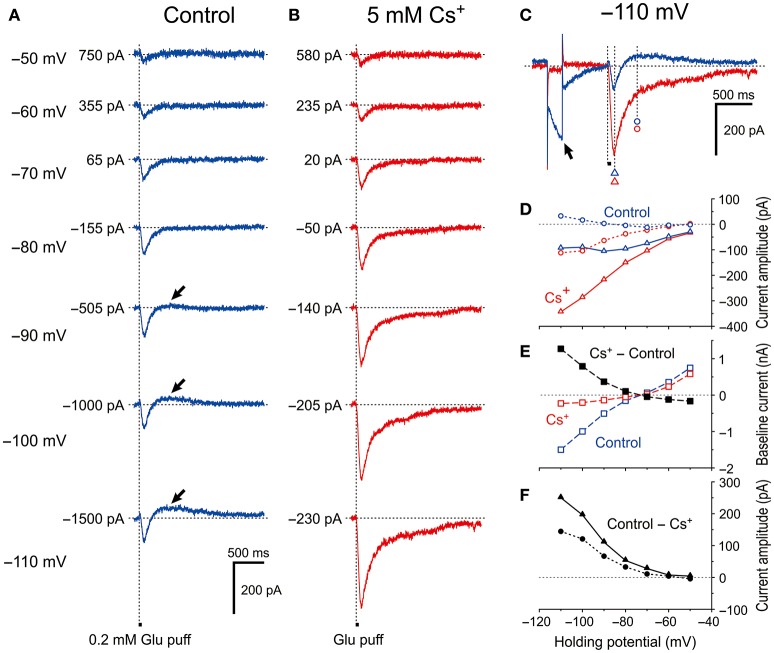
Voltage dependency of IGluR and effects of Cs+ on IGluR. (A) Current responses to 50-ms puff applications of 0.2 mM glutamate (IGluR) recorded under the voltage-clamp condition at holding potentials ranging between −110 anfd −50 mV in MTN neurons. (B) Bath application of 5 mM Cs+ outwardly shifted the baseline current level, enhanced the inward component of IGluR (IN-IGluR), and abolished the outward component of IGluR (OT-IGluR) seen at membrane potentials below −80 mV in the absence of Cs+. (C) Current responses at −110 mV obtained in the absence (blue trace) and presence (red trace) of Cs+. The baseline current levels were aligned. (D)
I-V relationships of IGluR obtained in the absence (blue symbols) and the presence (red symbols) of Cs+. The triangles and circles represent the peak amplitudes of IGluR and the amplitudes of IGluR measured at 300 ms after the onset of the puff application of glutamate at which time IGluR exhibited a peak value of the outward component at −110 mV, respectively. (E)
I-V relationships of the baseline current obtained in the absence (blue squares) and the presence (red squares) of Cs+. The black squares represent the amplitudes of outward shifts of the baseline current at respective holding potentials obtained by subtraction of the control response (blue squares) from that recorded during Cs+ application (red squares). (F)
I-V relationships of the Cs+-sensitive components of IGluR that were obtained by subtraction of the response recorded during Cs+ application (red symbols) from the control (blue symbols) shown in D. The filled triangles and circles represent the amplitudes of Cs+-sensitive IGluR measured at its peak and at 300 ms after the onset of puff, respectively.